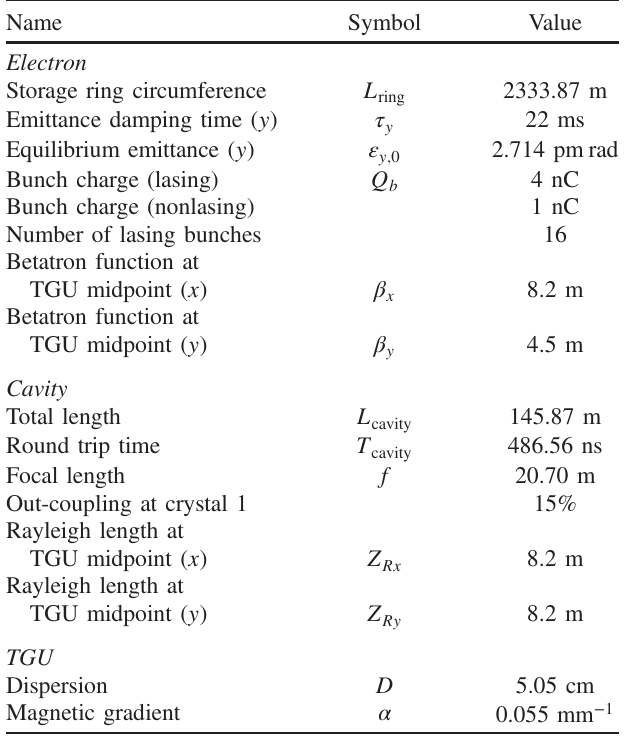
TABLE III. Additional beam parameters used for the simu- lation study. Unless otherwise stated, all other machine param- eters are same as those provided in Table I.